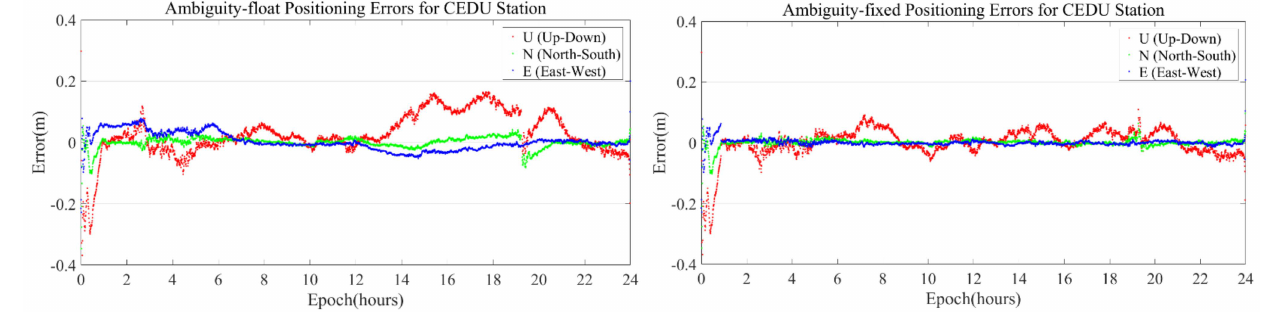
Figure 2. The time series of CEDU station position errors between the ambiguity-float ( left subgraph ) or ambiguity-fixed ( right subgraph ) solution and IGS-released